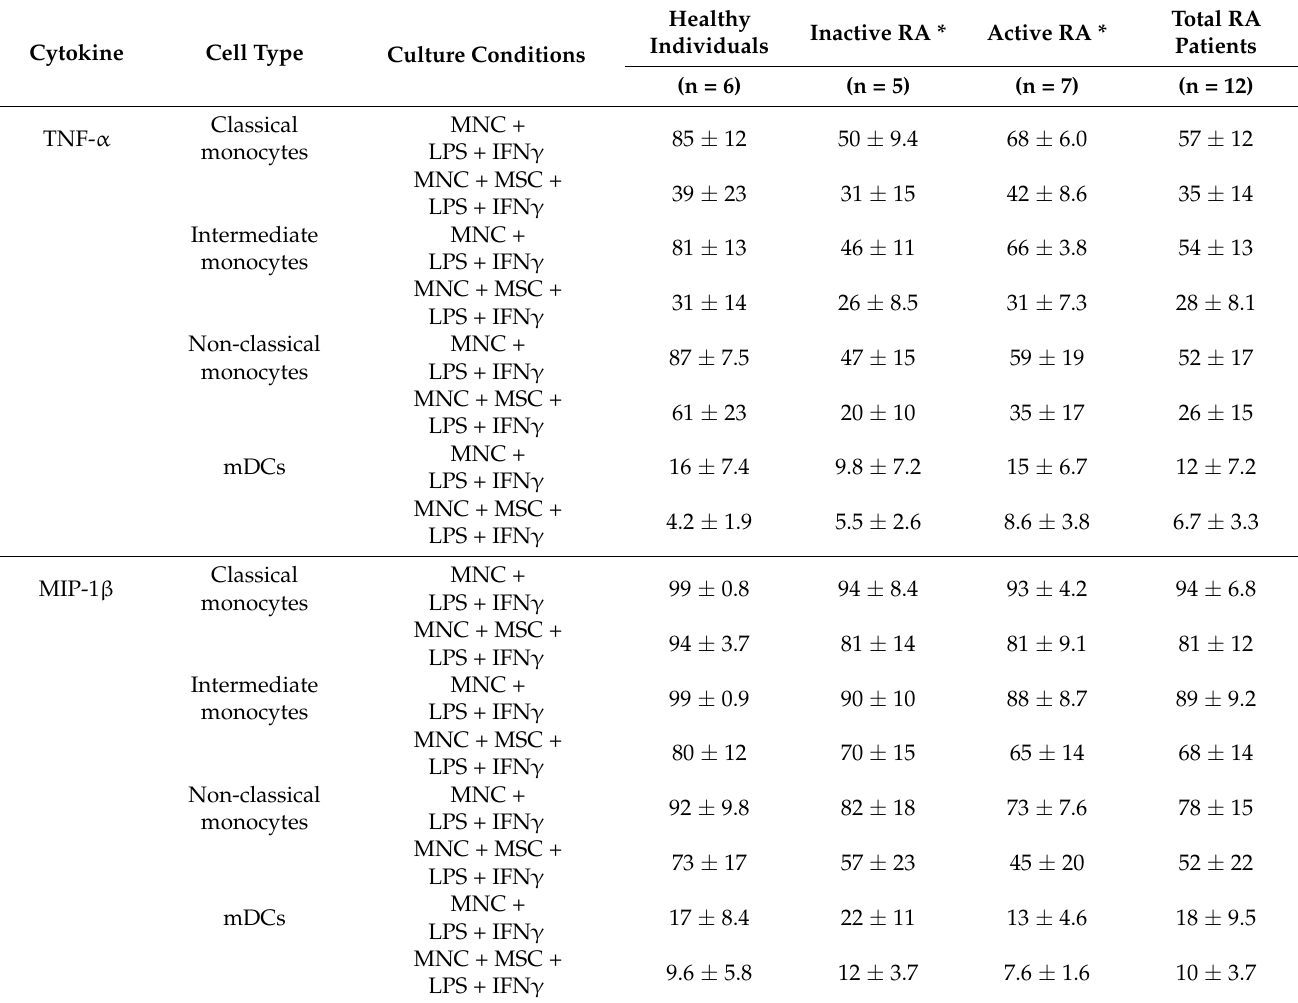
Table A2. Effect of MSCs on the percentage (%) of cells producing cytokines (mean ± standard deviation), upon stimulation with LPS and IFN γ